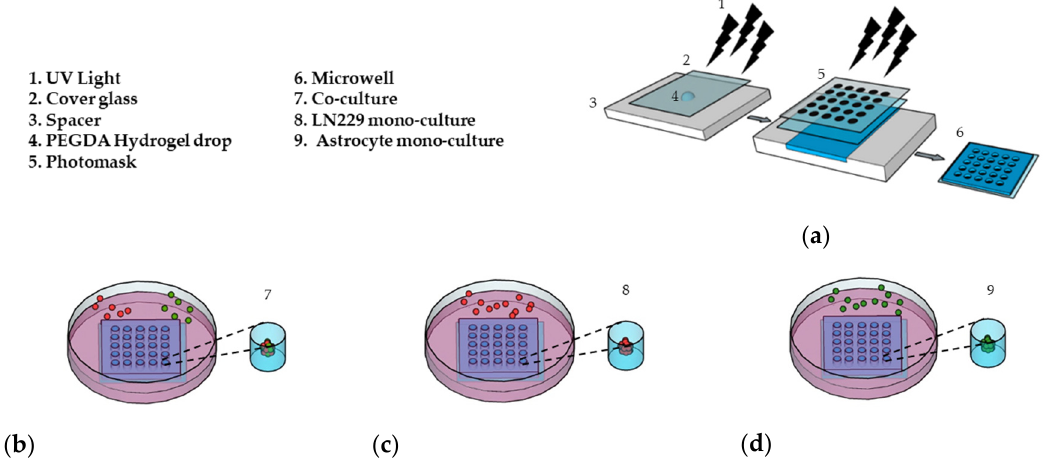
Figure 1. Preparation of the 3D cell culture in the (PEGDA) microwells. ( a ) Schematic of the PEGDA microwells’ fabrication using a round pattern photomask (400 µ m in diameter). ( b ) LN229 cells stained with a red cell tracker and astrocytes stained with a green cell tracker were added into the microwells and co-cultured with a ratio of 1:1 (LN229:astrocytes) for 7 days. ( c ) LN229 cells were mono-cultured into microwells for 7 days. ( d ) Astrocytes cells were mono-cultured into microwells for 7 days.